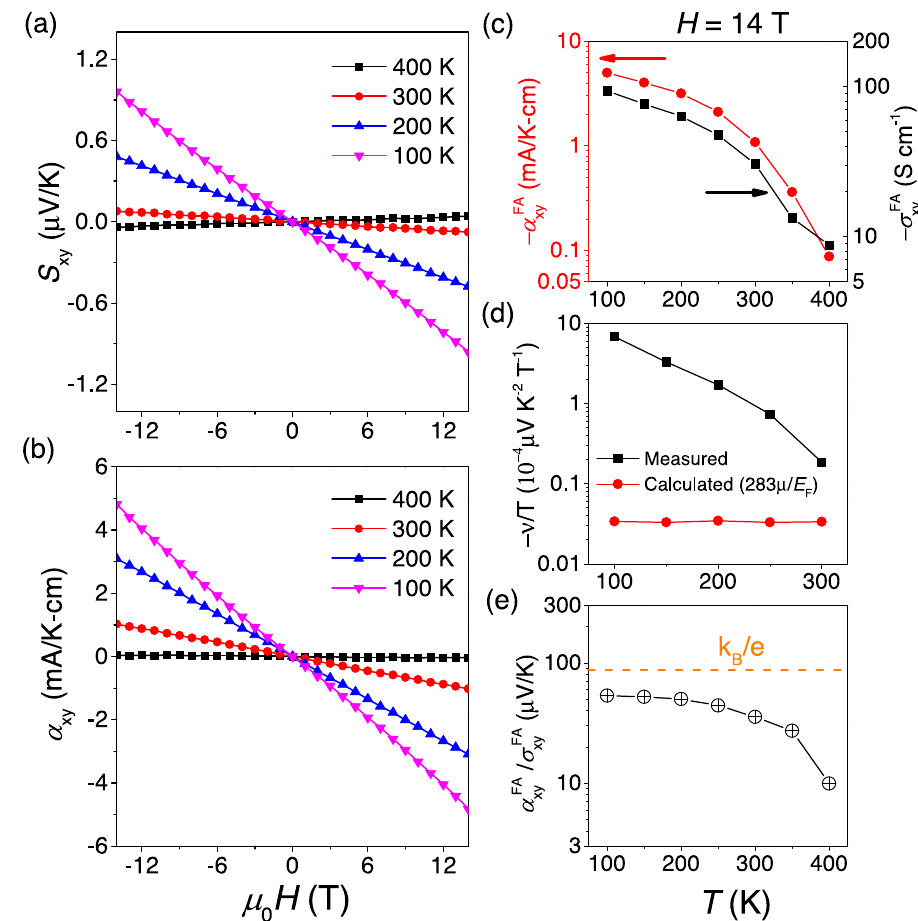
Fig. 4 | Field induced anomalous Nernst effect. a , b Field dependence of S xy and α xy up to 14 T, with temperature varying from 100 to 400 K. c Comparison of temperaturedependenceof σ FA xy and α FA xy at14T. d Temperaturedependenceofthe Nernst coef fi cient ( υ = S xy / H ) divided by temperature. Measured Nernst signal (the black squares) with the largest value of 6.85 10 − 4 μ VK − 2 T − 1 , becomes two orders of